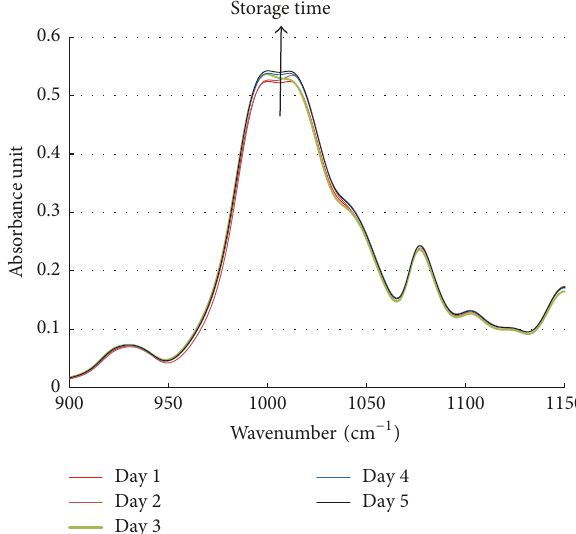
Figure 8: Amplified mean spectra of the normalized bread spec- tra over 5 days of storage at freezing temperature in the band 900–1150CM −1